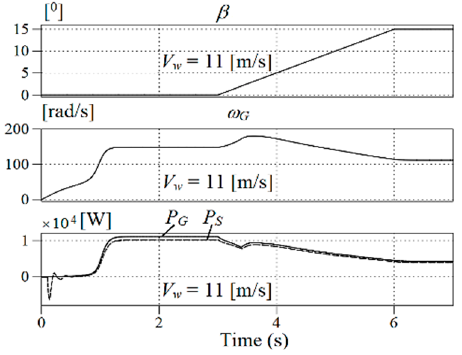
Figure 14. The waveforms of the angle of the wind turbine blades β , the angular velocity ω G , the power P G and supplied to the power grid P S .